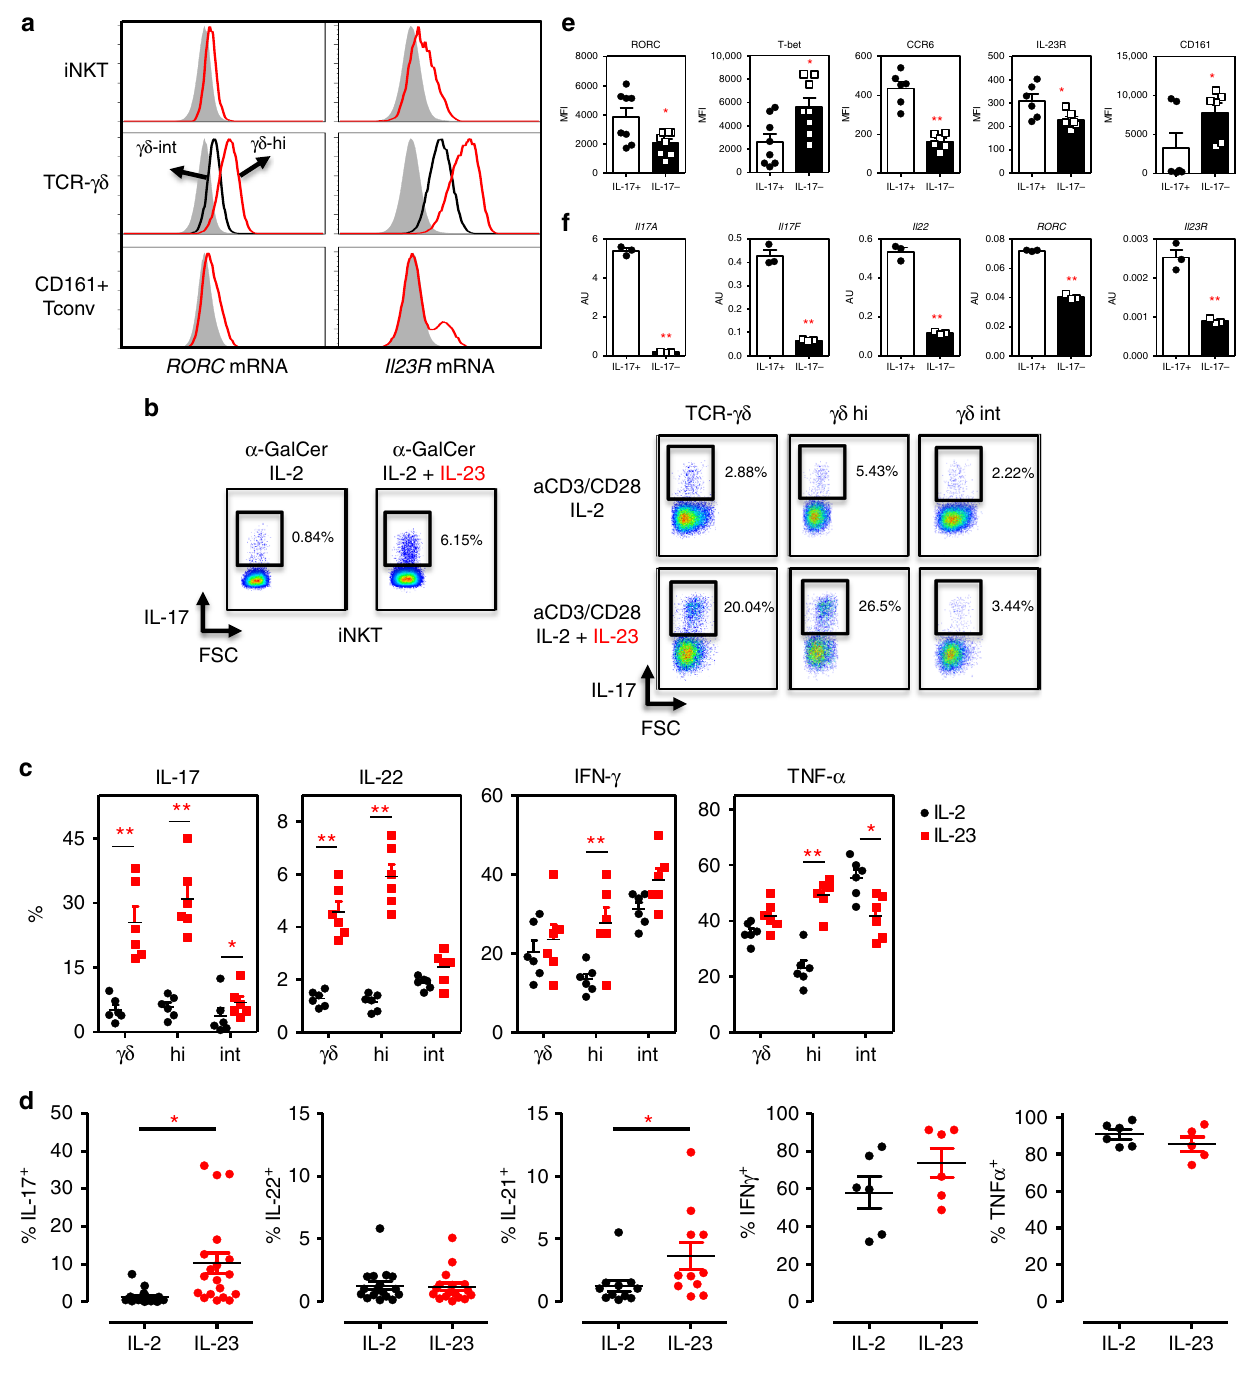
Fig. 2 iNKT and γδ -T cells are armed for a competent IL-23 response. a RORC and IL23R mRNA transcripts expressed in iNKT, TCR γδ -hi/int, and CD161 + conventional T cells as measured by PrimeFlow technology ( n = 3). Gray histograms represent FMO. Quantitative data are presented in Supplementary Fig. 2B. b PBMC (left) or sorted γδ -T cells were cultured with α GalCer (PBMC, n = 18) or aCD3/aCD28 Abs ( γδ -T cells, n = 6), in the presence of IL-2 or IL-2 supplemented with IL-23, IL1 β , TGF β 1 to induce IL-17 cytokine response as measured from viable iNKT (6B11 + TCRv β 11 + CD3 + cells) or γδ -T cells (TCR γδ + CD3 + ). Flow data from one representative experiment is shown. c , d Quantitative overview of cytokine production measured in γδ -T cell (C; IL-2: black symbols; IL-23: red symbols) and iNKT (D, IL-2 condition: black symbols; IL-23: red symbols) cultures as described in b (IL-23 vs. IL-2 condition, * p < 0.05, ** p < 0.01 determined by paired t -tests). e FACS analyses were performed on gated IL17 + and IL17 − iNKT cells depicted in experiments described in b ( n = 6 – 8). * p < 0.05, ** p < 0.01 determined by paired t-tests (IL-17- cells: black bars; IL-17 + : white bars). f qPCR assays on selected target genes, were performed on IL17 + and IL-17 − iNKT cells isolated by means of a IL-17 Capture Assay (qPCR, n = 3, Mann-Whitney test). (IL-17- cells: black bars; IL-17 + : white bars). Data throughout this fi gure are presented as mean ±